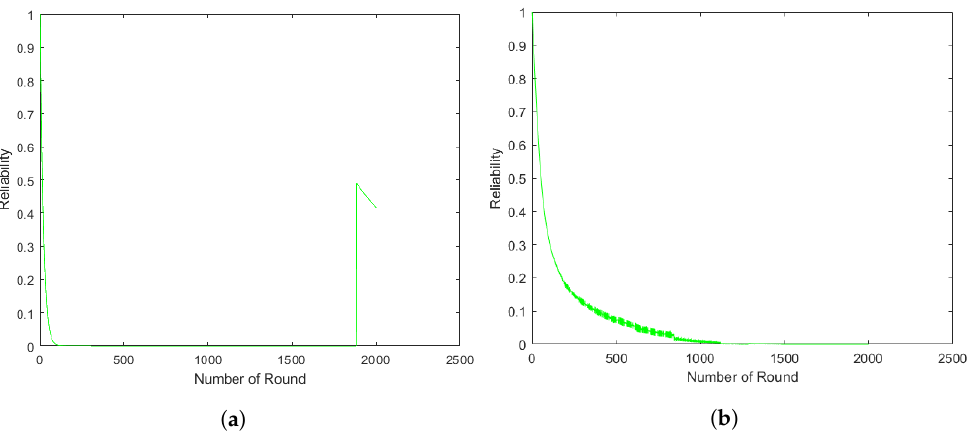
Figure 22. Single-chain mobile CH energy reliability-based proposed RBD: ( a ) D-Chain, ( b )